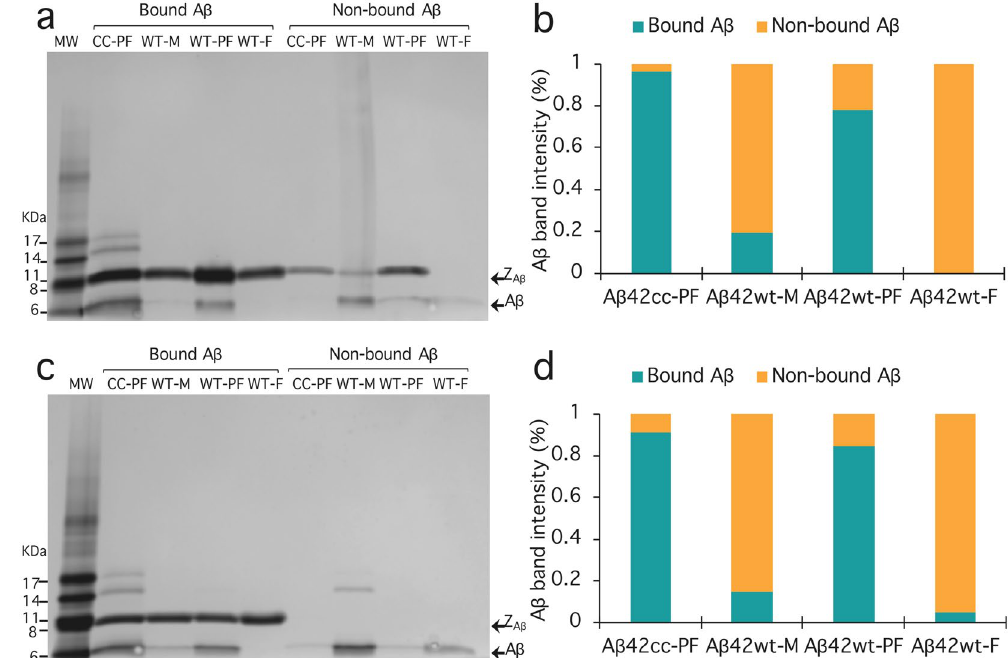
Figure 3. Binding of Affibody molecules to various A β aggregates and monomer in a batch mode affinity experiment. The SDS-PAGE analysis shows that Affibody Z A β 42cc_1 ( a ) and Z A β 42cc_4 ( c ) recognize protofibrillar aggregates of A β 42 cc and A β 42 wt (bound A β ). Wild type monomer and fibrils did not bind to the Affibody molecules and were recovered in the supernatant (non-bound A β ). The designations MW, CC-PF, WT-M, WT-PF and WT-F refer to molecular weight marker (GE Healthcare), A β 42 cc protofibrils, A β 42 wt monomer, A β 42 wt protofibrils and A β 42 wt fibrils, respectively. ( b ) and ( d ), A β band intensity for Z A β 42cc_1 and Z A β 42cc_4 , respectively. The band intensities were obtained with the graphic program ImageJ 32 . The data was normalized with respect to each A β -species, i.e. the sum of the intensities for bands originating from one A β -species is equal to 100%.